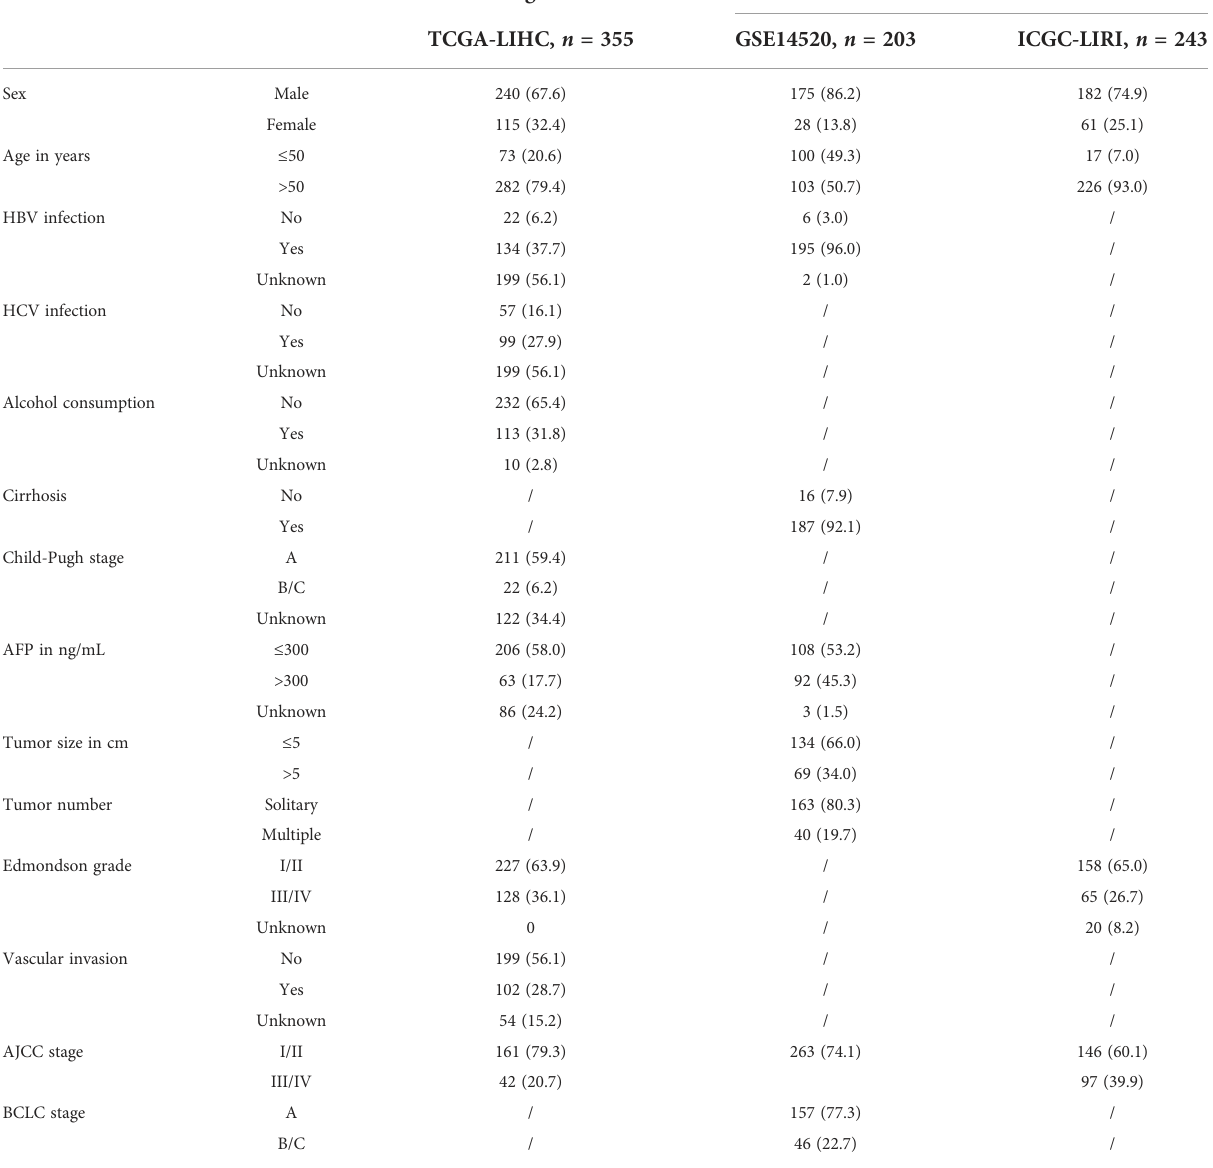
TABLE 1 Baseline characteristics of patients in the training and two validation